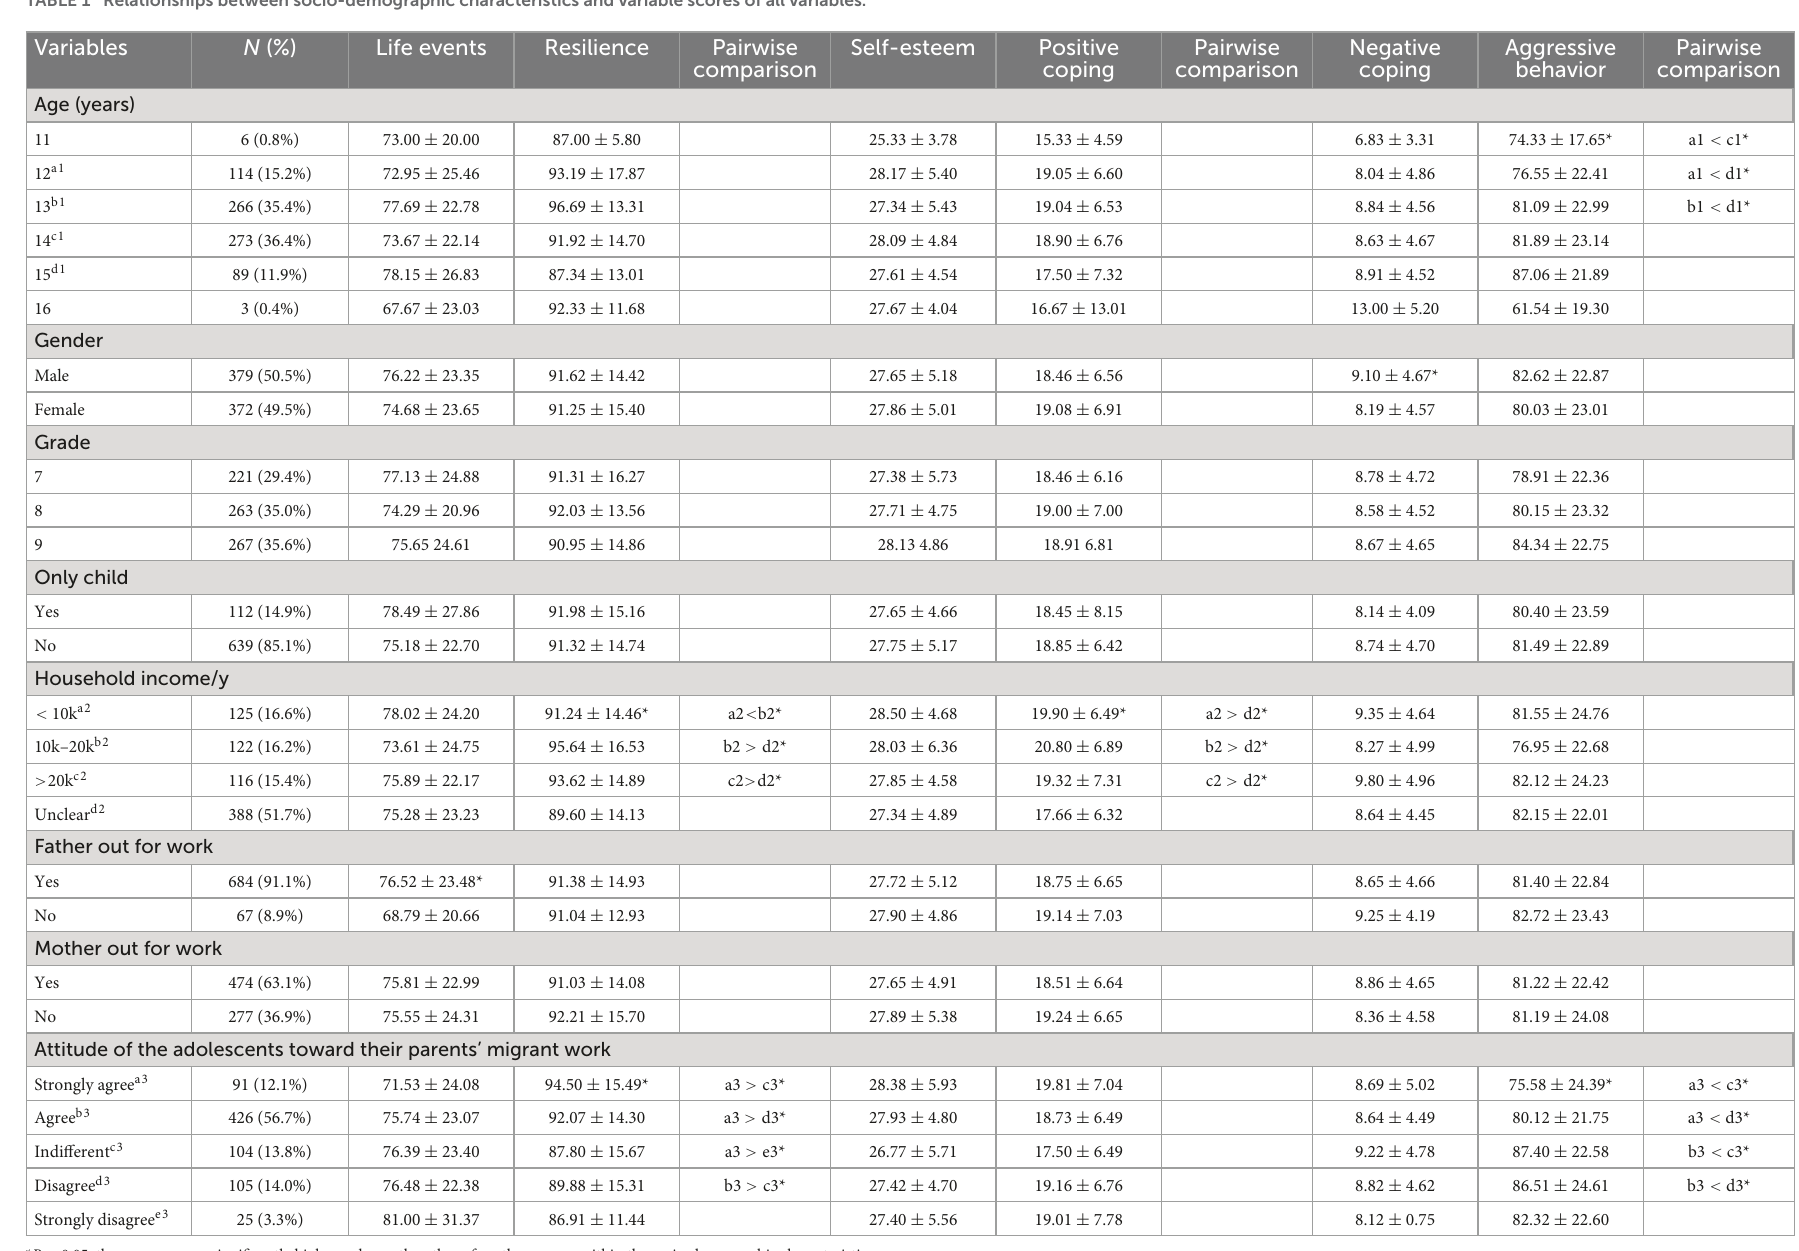
TABLE 1 Relationships between socio-demographic characteristics and variable scores of all